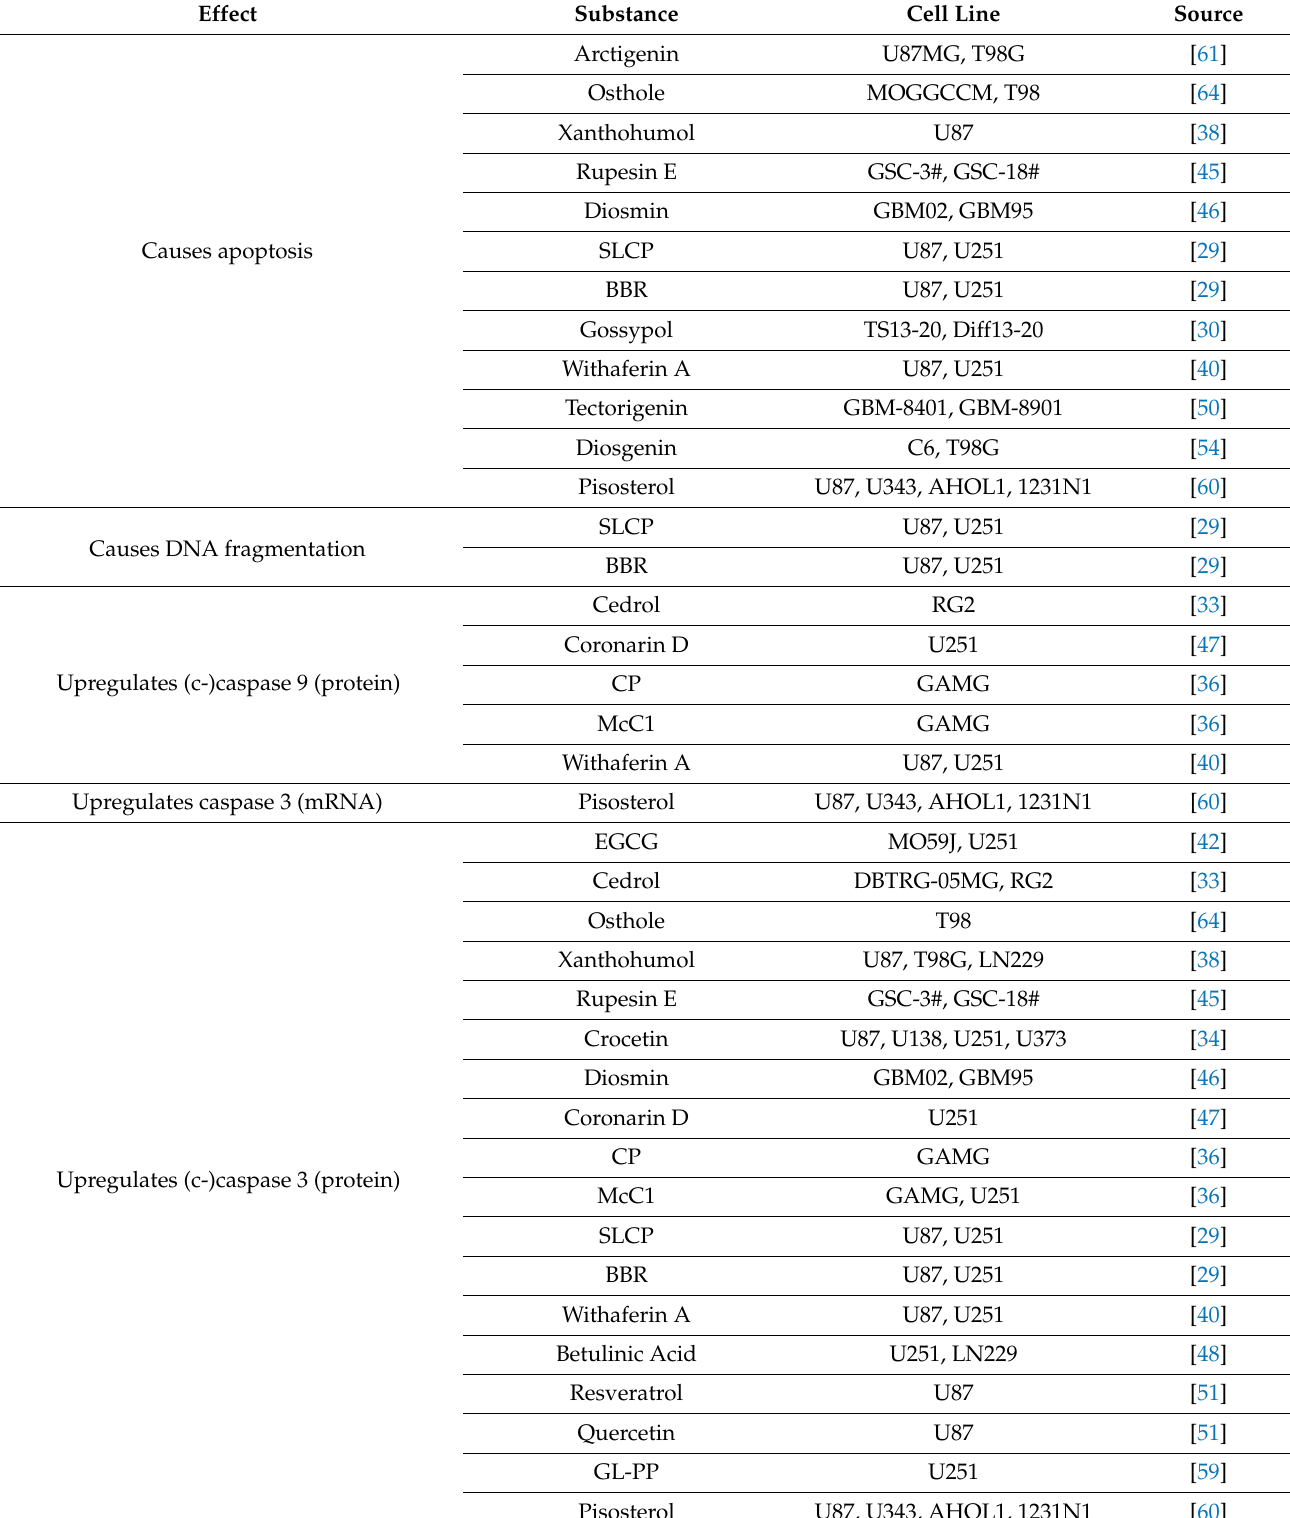
Table 4. Natural substances increase apoptotic cell death in GBM by downregulating apoptotic inhibitors and upregulating active caspases, which cleave PARP-1 and induce DNA